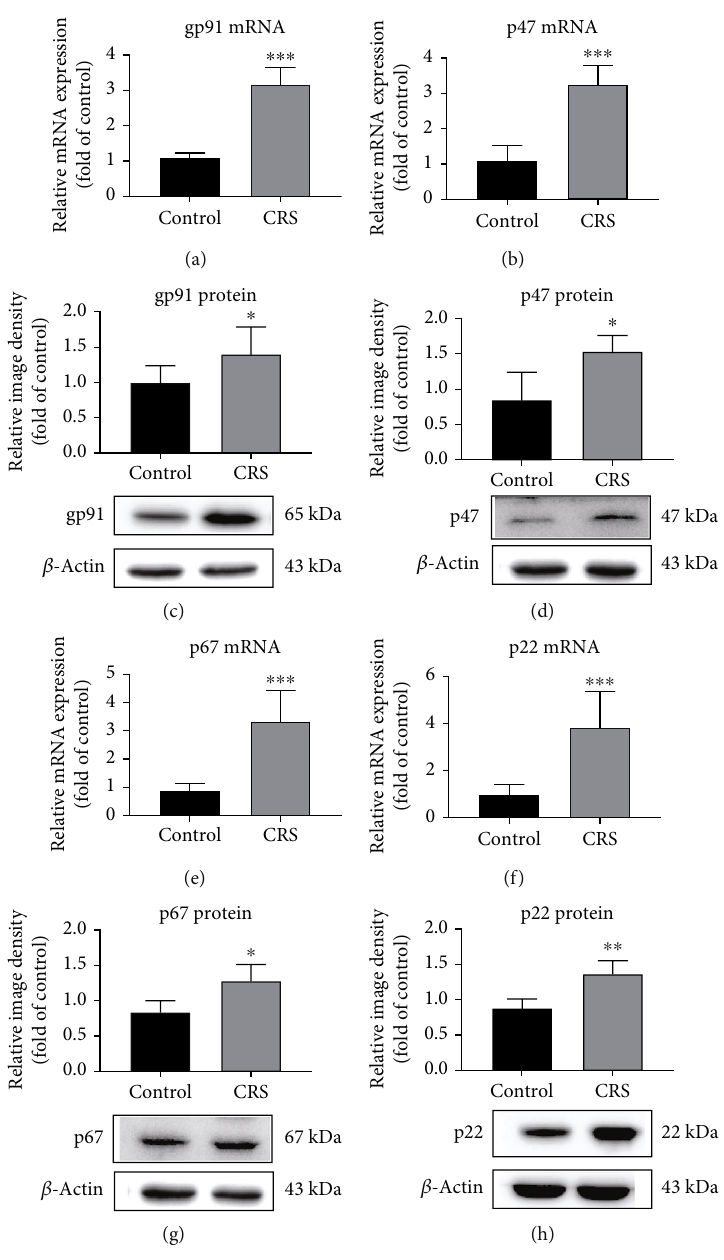
Figure 5: CRS increased the expression of NOX subunits in microvasculature. (a, c) CRS could increase the expression of mRNA and protein of gp91 phox . (b, d) CRS could promote the expression level of mRNA and protein of p47 phox . (e, g) mRNA and protein expressions of p67 phox were upregulated upon CRS. (f, h) mRNA and protein expressions of p22 phox were increased after CRS. Representative immunoblots are displayed under the graphs. Values are mean ± SE . ∗ p < 0 : 05 , ∗∗ p < 0 : 01 , and ∗∗∗ p < 0 : 001 , as compared with the control